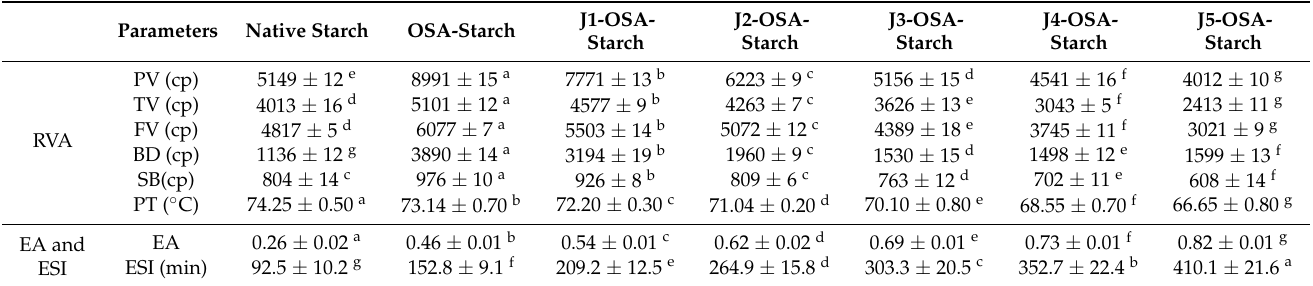
Table 4. RVA, EA, and ESI analysis of the native starch and J-OSA-starch